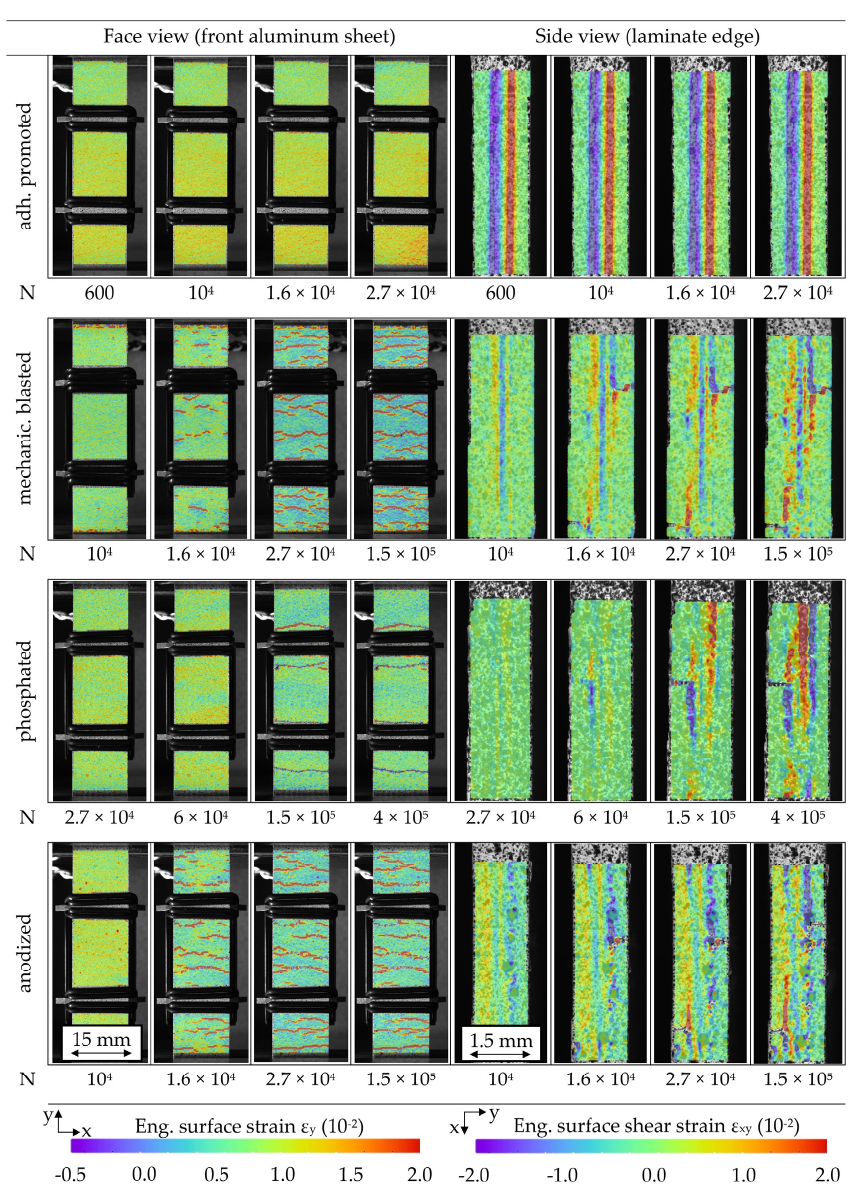
Figure 16. Digital image correlation-based strain analysis images of the front aluminum perspective and in-plane laminate perspective at defined constant amplitude test cycles ( σ max = 300 MPa, phosphated 290 MPa) for hybrid laminates with different aluminum surface treatments.